Question: What kind of plot is shown here?
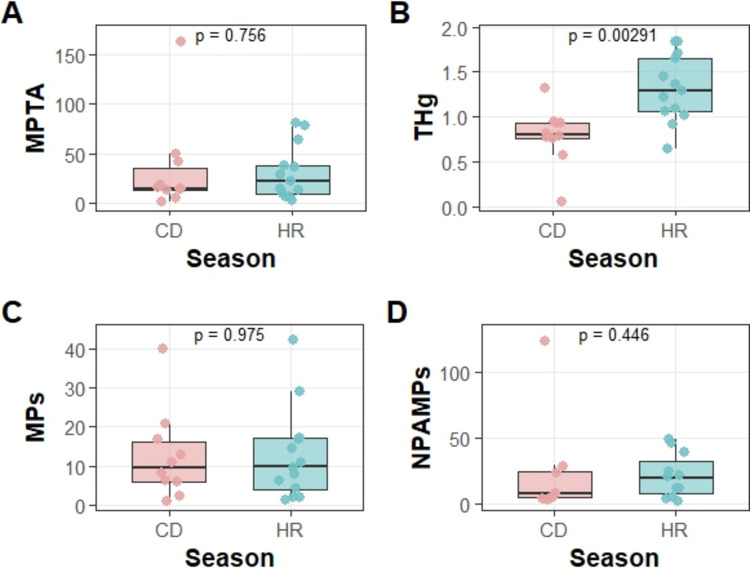
Answer: box